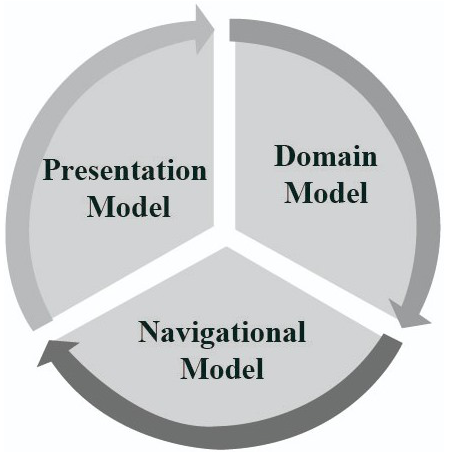
Figure 1. Web design